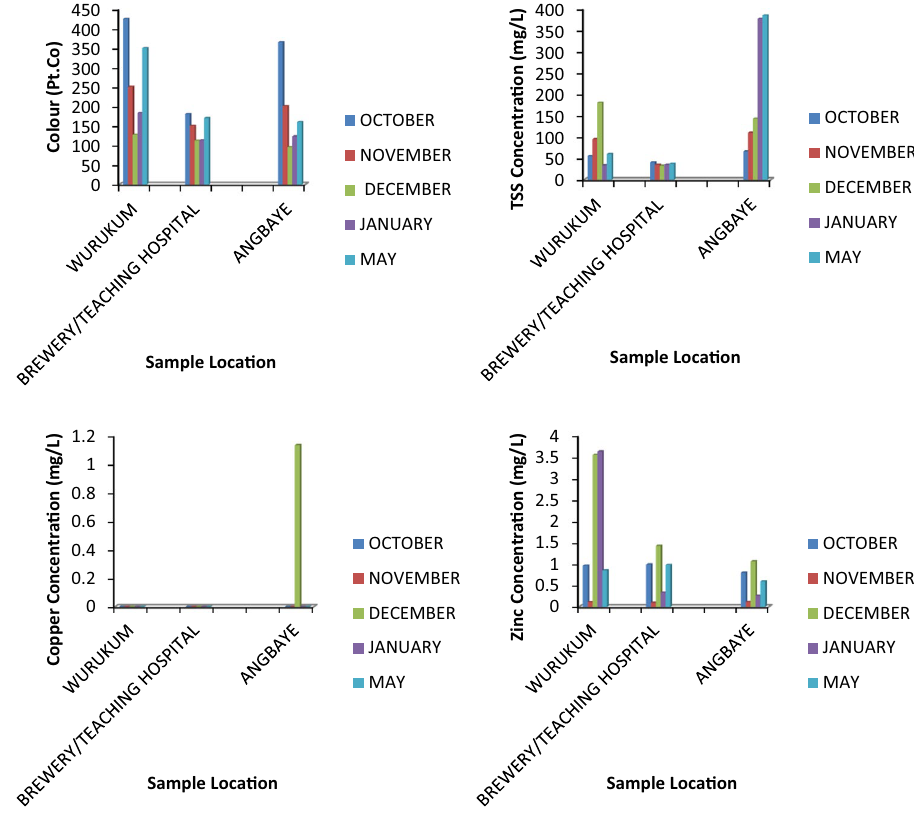
Fig. 5 Spatio-temporal vari- ations in colour, TSS, copper and zinc